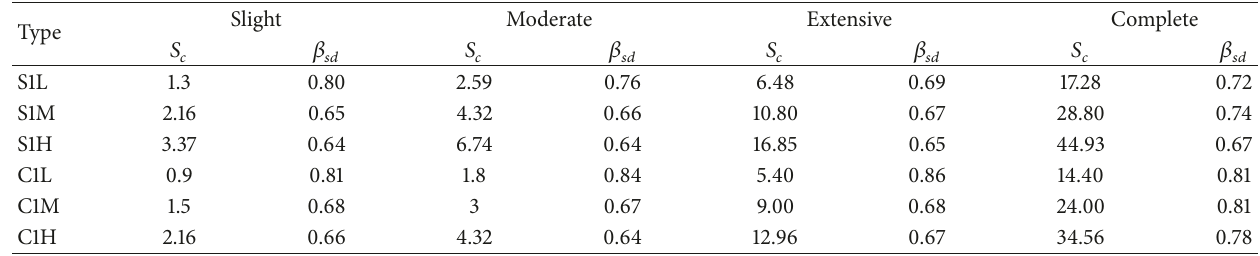
Table 3: Values of 𝑆 𝑐 and 𝛽 𝑠𝑑 according to [1].